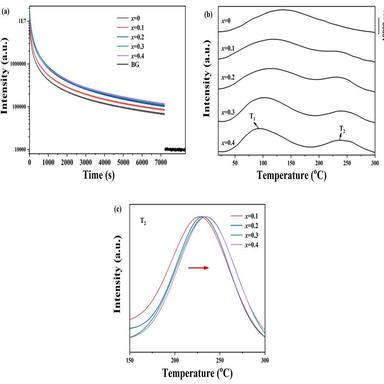
(a) NIR persistent luminescence decay curves (monitored at 694 nm after 254-nm UV light illumination for 5 min) (b) TL glow curves and (c) normalized T2 curves of ZGSO:Cr3+ (x = 0-0.4).